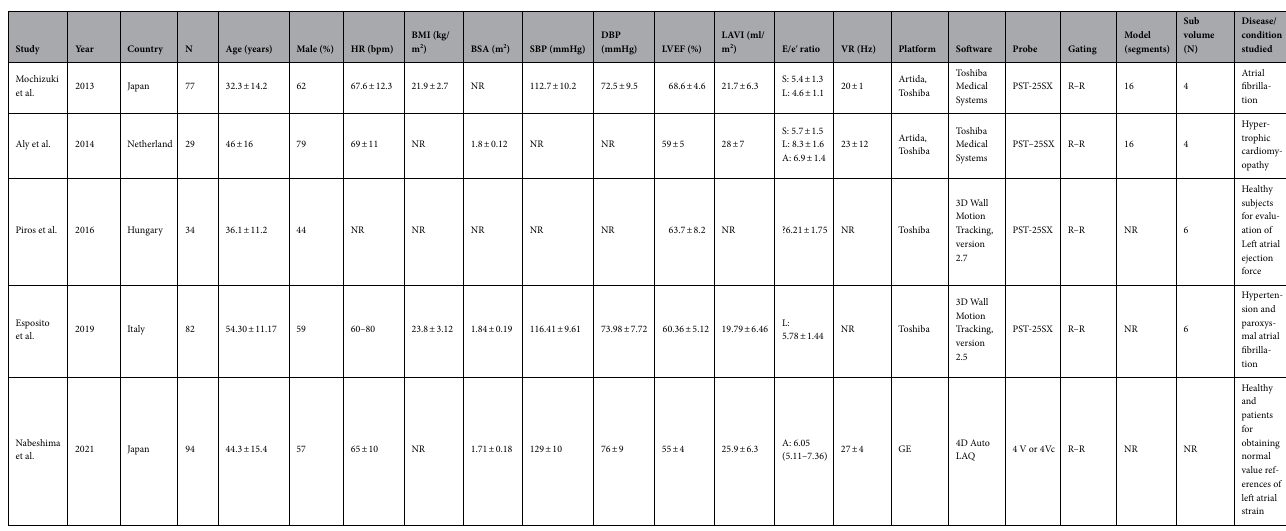
Table 1. Study characteristics. ?, not defined. A averaged septal and lateral value, BMI body mass index, BSA body surface area, DBP diastolic blood pressure, HR heart rate, L lateral, LAVI left atrial volume index,